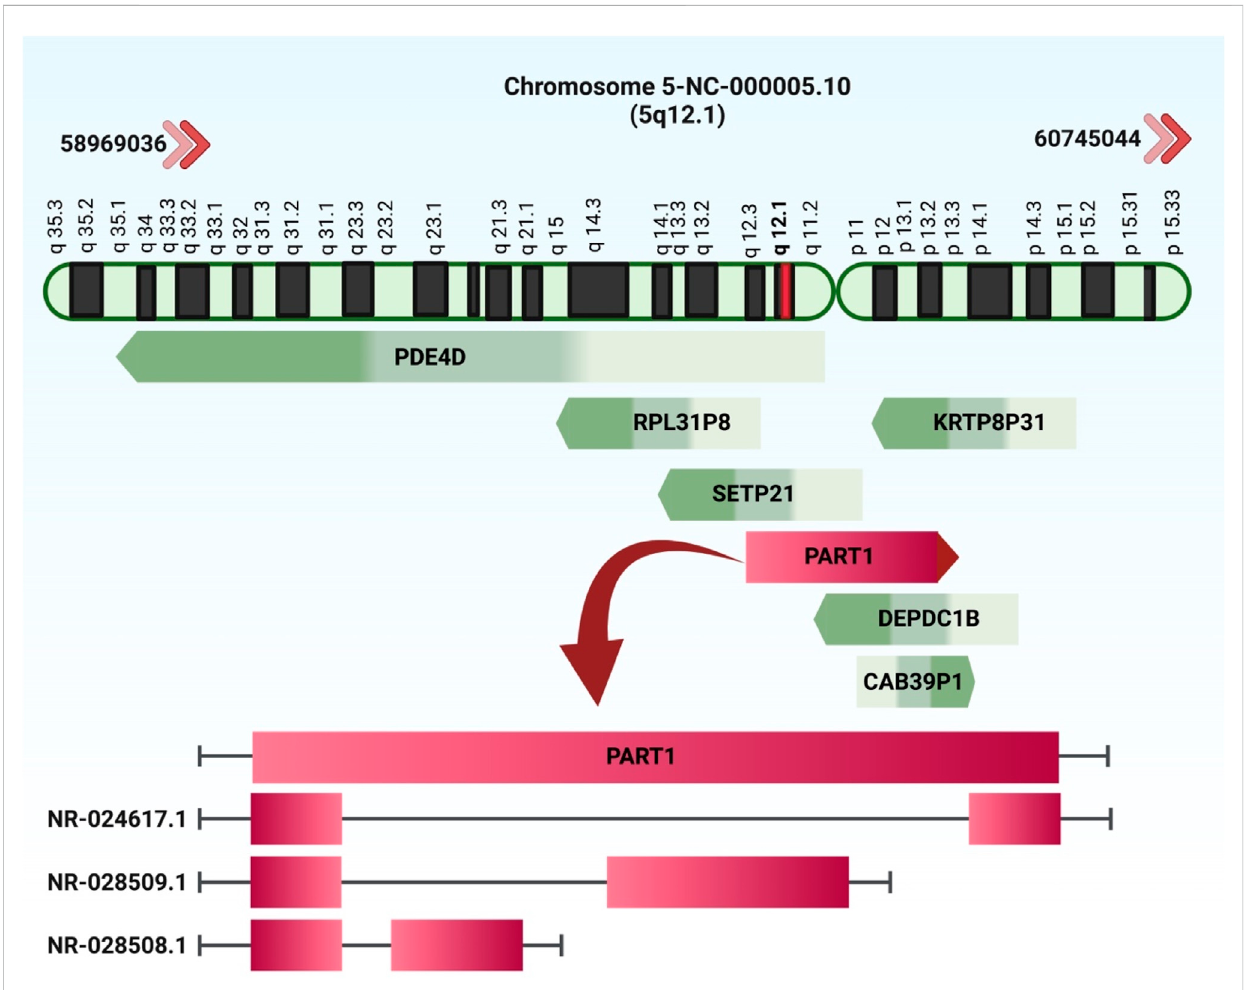
FIGURE 1 The chromosomal location of the prostate androgen-regulated transcript 1 (PART1) was initially identi fi ed in PCa. The NCBI database reveals the existence of three transcripts: NR 024617.1 (2.5 kb), NR 028509.1 (5.9 kb), and NR 028508.1 (2.1 kb).